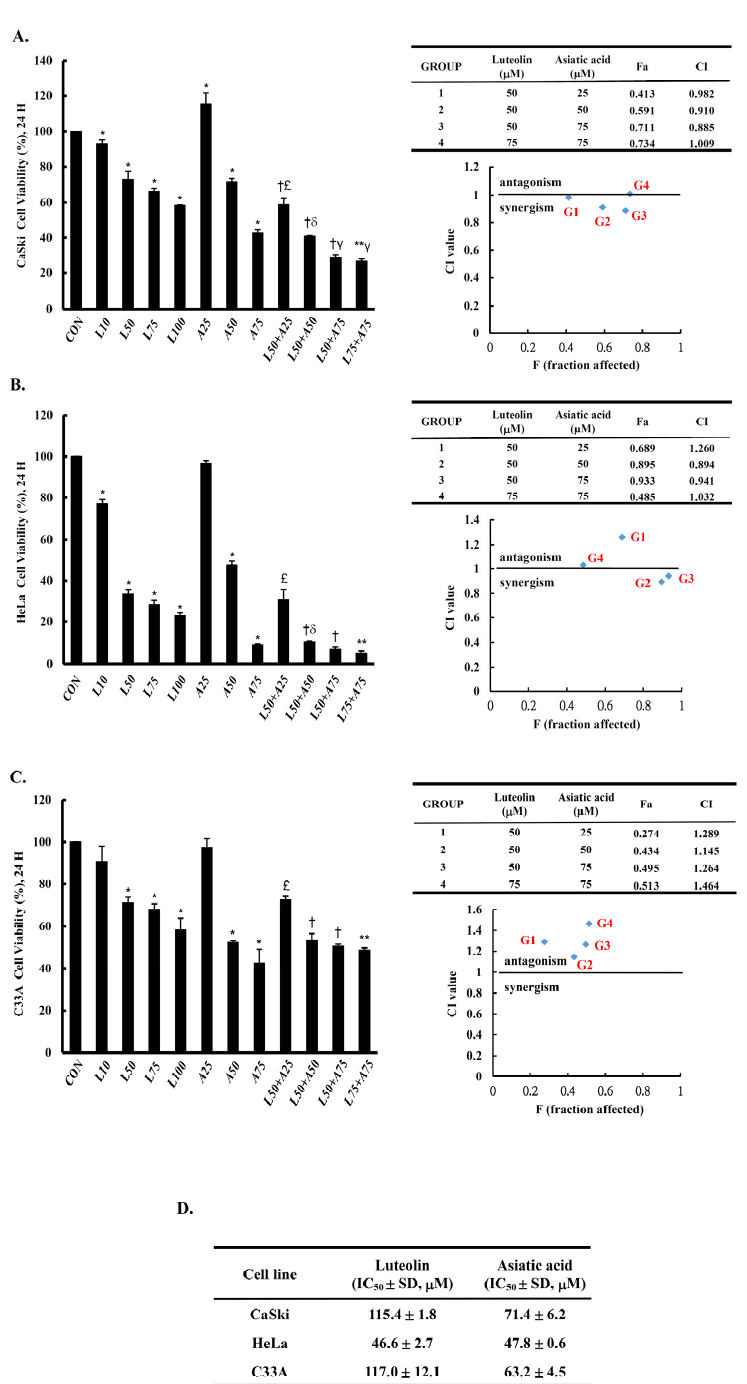
Figure 1. Luteolin and asiatic acid inhibited the proliferation of cervical cancer cell lines. CaSki ( A ), HeLa ( B ) and C33A ( C ) cell proliferation was measured using a CCK-8 assay after cells were exposed to Lut or AsA alone or in combination. ( D ) IC50 values for luteolin and asiatic acid treatments in cervical cancer cells. Values represent mean ± SD from three replicates. *, †, **, £, δ and γ p < 0.05 compared with CON, L50-, L75-, A25-, A50- or A75-treated group. CON, 0.1% DMSO; L10, 10 µ M luteolin; L50, 50 µ M luteolin; L75, 75 µ M luteolin; L100, 100 µ M luteolin; A25, 25 µ M asiatic acid; A50, 50 µ M asiatic acid; A75, 75 µ M asiatic acid. CI, combination index, IC 50 , half maximal inhibitory concentration. G1, 50 µ M luteolin + 25 µ M asiatic acid; G2, 50 µ M luteolin + 50 µ M asiatic acid; G3, 50 µ M luteolin + 75 µ M asiatic acid; G4, 75 µ M luteolin + 75 µ M asiatic acid; blue mark, combination index